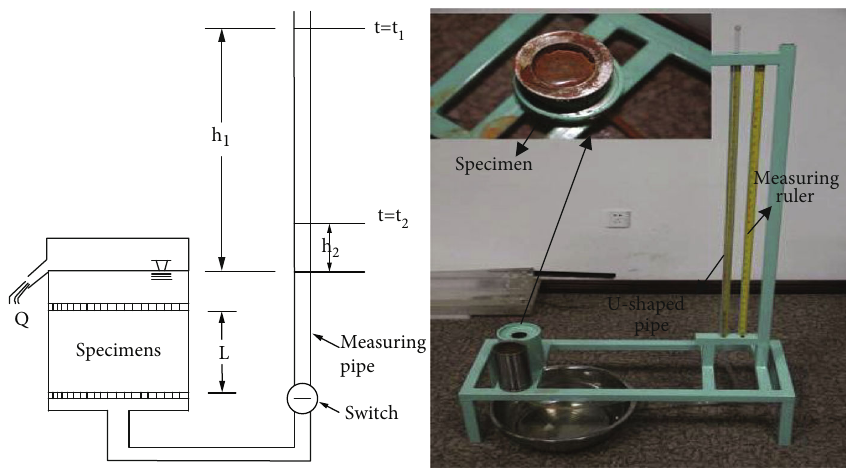
Figure 11: The permeability coe ffi cients of some specimens. Table 2: The permeability coe ffi cients of some specimens. Specimen